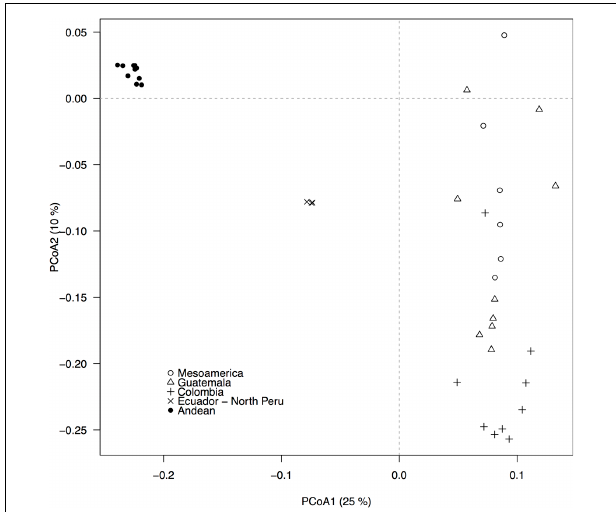
FIGURE 2 | Population structure, as revealed by a principal coordinates analysis (PCoA), based on 22,845 GBS-derived SNP markers. Filled and empty symbols correspond to accessions from the Andean and the Mesoamerican genepool, respectively. Five within-genepool subpopulations, according to Blair et al. (2012), are indicated by different symbols. The percentage of explained variation by each axis is shown within parenthesis in the label of the correspond axis.